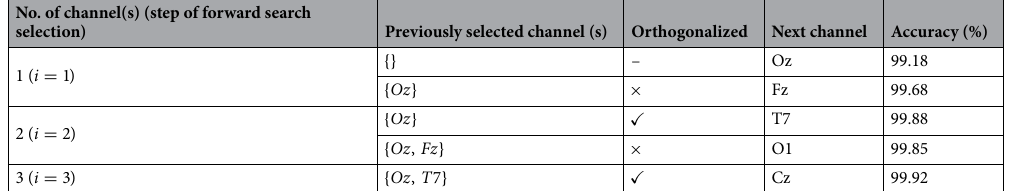
Table 3. Best Channel selected in each step of the forward search selection with (gray rows) and without (white rows) the orthogonalization.